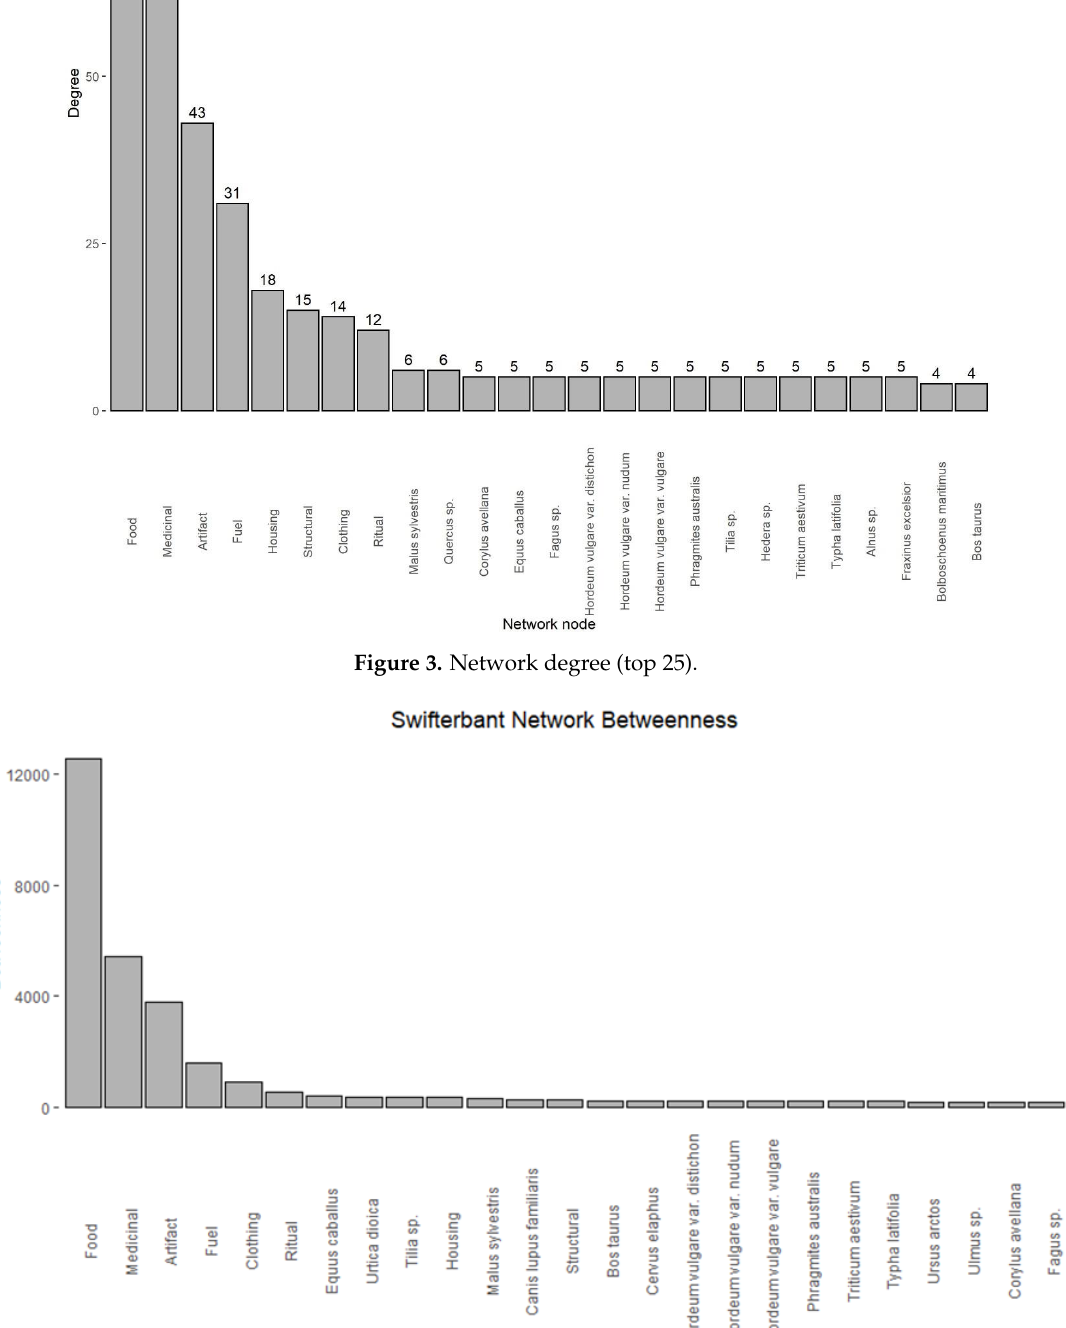
Figure 4. Network betweenness (top 25).